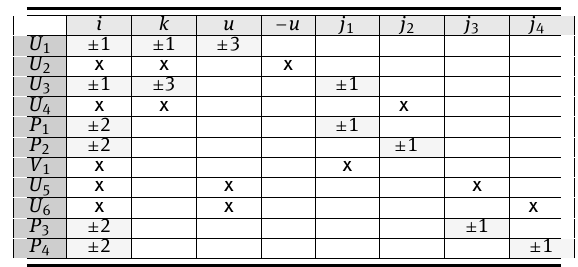
Table 11. Index distribution on C i ∪ D i ∪ E i and on 4 words of type [± 2, ± 1 ]